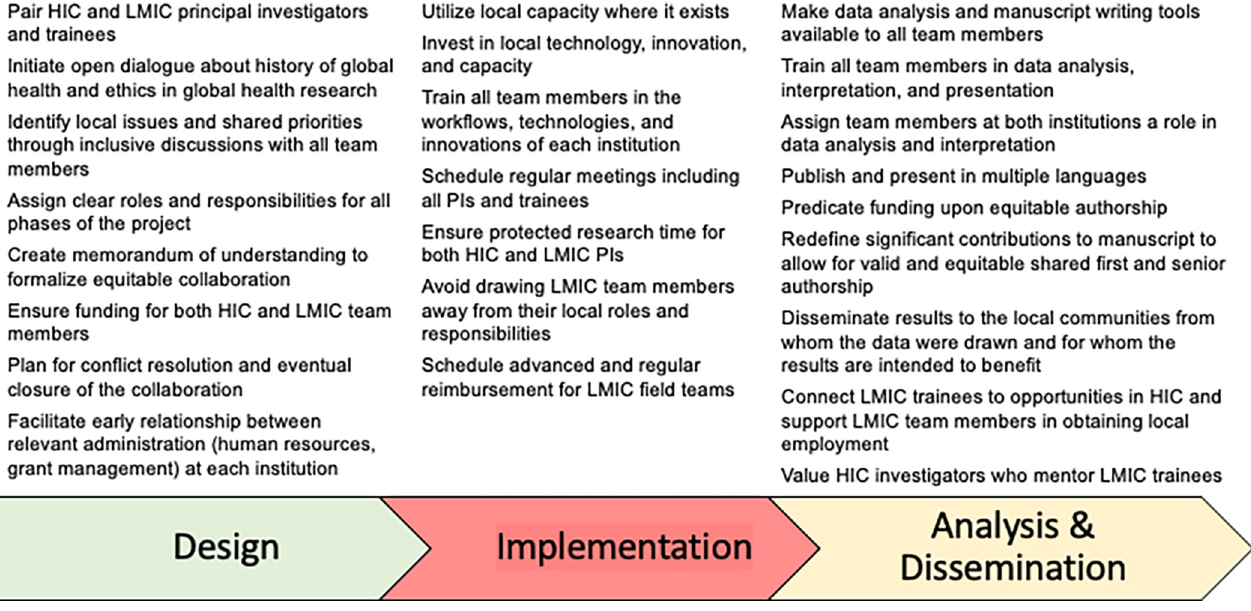
Fig 1. Recommendations for advancing equity in global health during each phase of